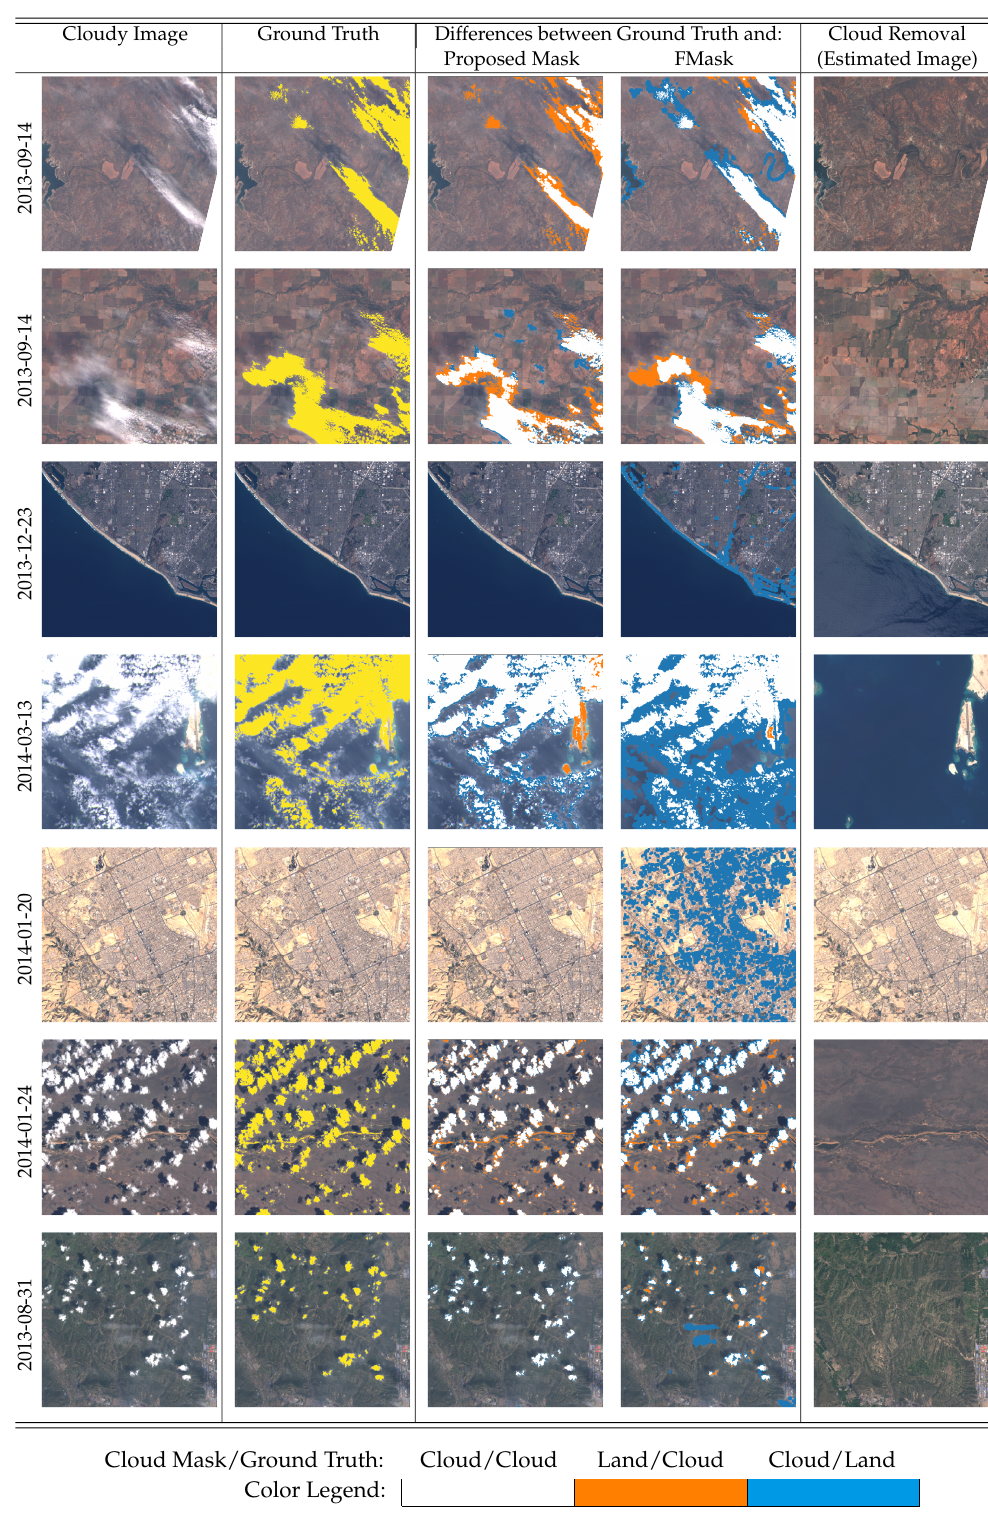
Figure 8. Patches of 500 × 500 pixels from Biome dataset. From left to right: RGB scene, RGB scene with ground truth cloud mask in yellow, differences between ground truth and the proposed cloud mask (using the median as background estimation), difference between ground truth and FMask, and estimated cloud-free